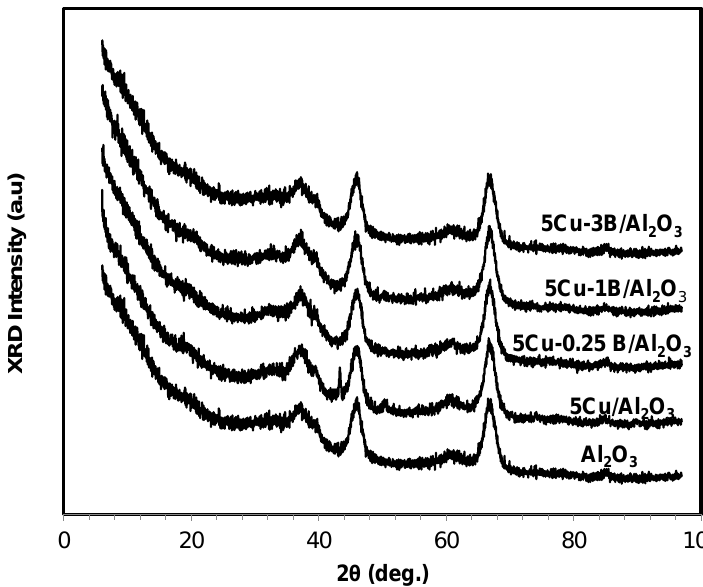
Figure 1. XRD pattern of the fresh Cu/Al 2 O 3 catalysts loaded with various amounts of B 2 O 3 .